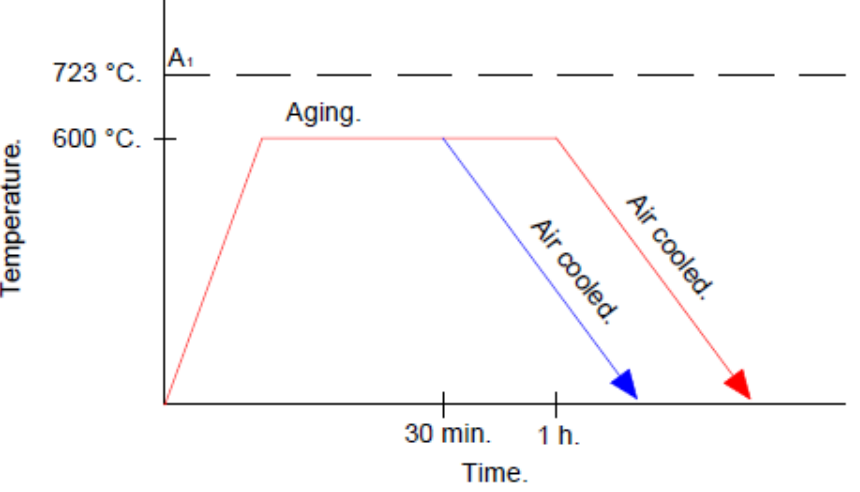
Figure 1. Aging treatments